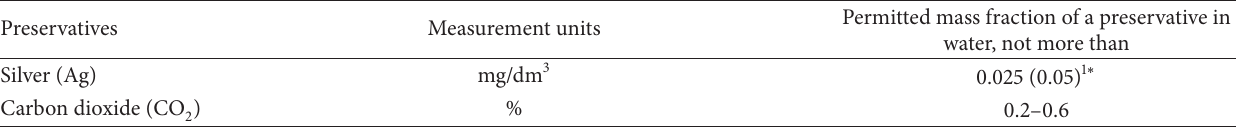
Table 8: Reagents permitted as preservatives for drinking